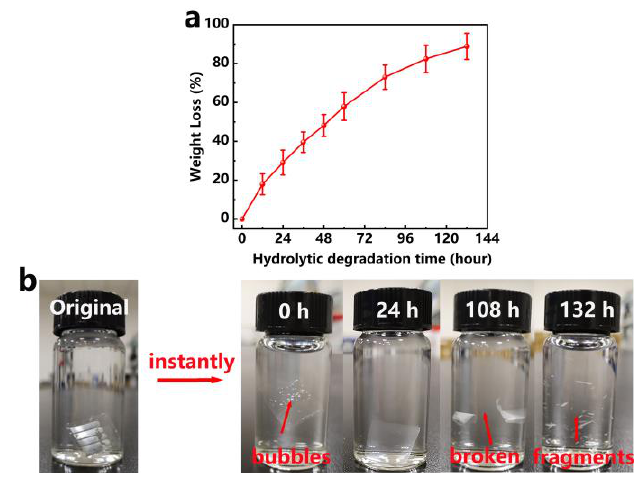
Figure 6. ( a ) Hydrolytic degradation rate of the OLEDs based on the AgNW/PLLA:PDLA film. ( b ) Photographs of the OLEDs immersed into NaOH solution for different hours.